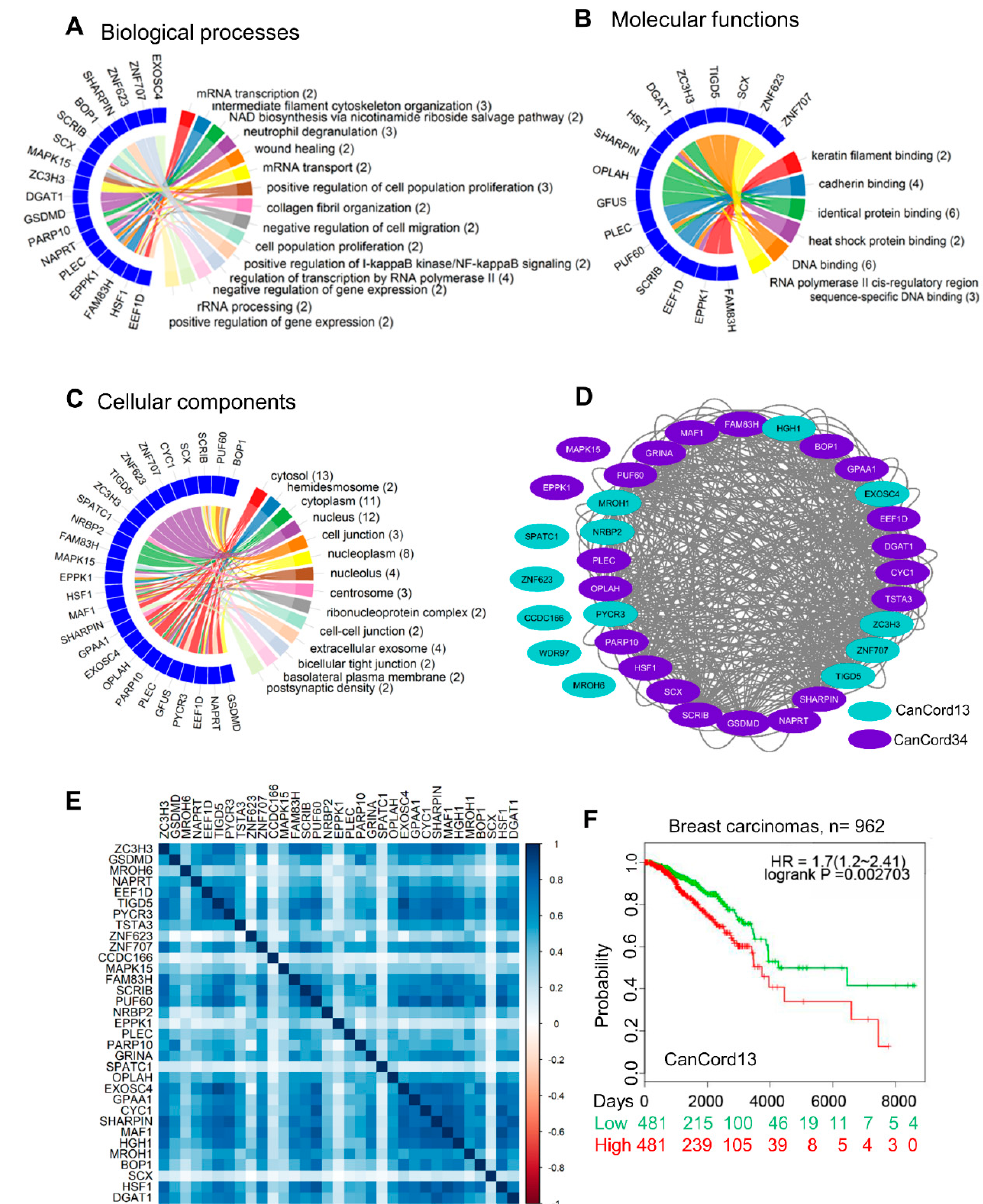
Figure 3. Functional enrichment analysis of CanCord34 genes. ( A ) Biological processes. ( B ) Molecular function. ( C ) Cellular components. Gene ontology enrichment analyses were performed using the NeVOmics functional annotation program and represented using Circos plots. ( D ) Circular network representing the CanCord34 inter-correlation. Node colors represent the class of genes as CanCord13 and CanCord34. ( E ) Functional protein–protein interaction using the online STRING